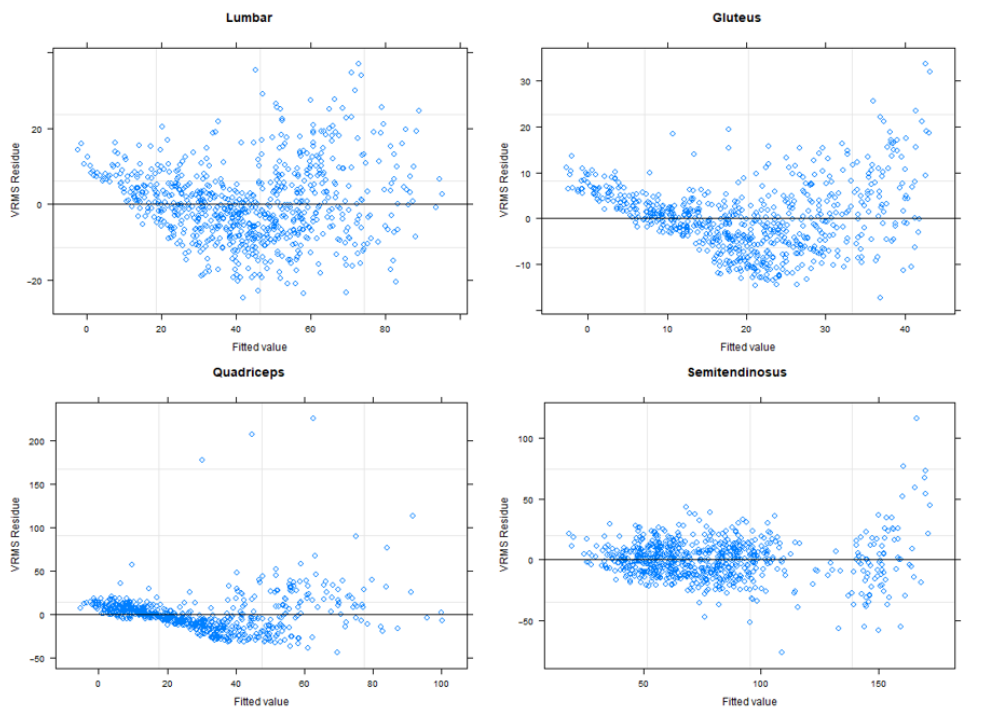
Figure A1. Plot of residues, fitted values minus observed values, over the fitted values for VRMS for each muscle mixed model.